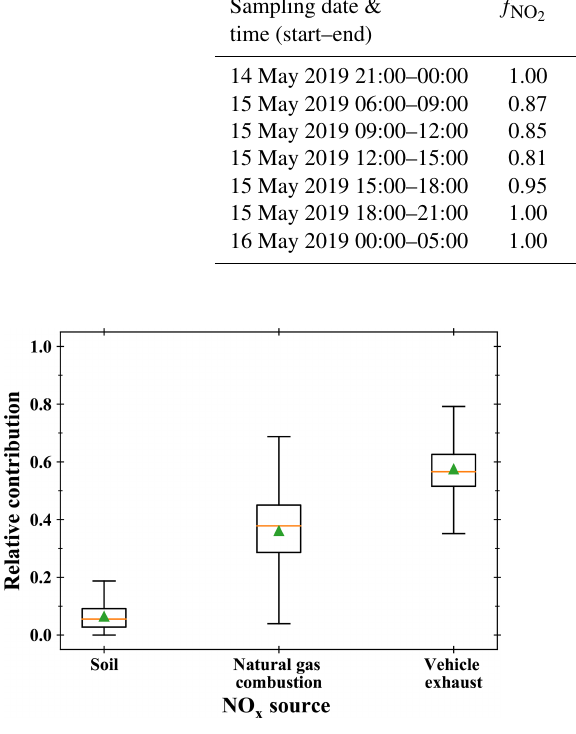
Figure 5. Potential NO x emission source partitioning using the SIAR model based on estimated δ 15 N(NO x ). Reference values for each source were taken from Miller et al. (2017), Walters et al. (2015), and Zong et al.